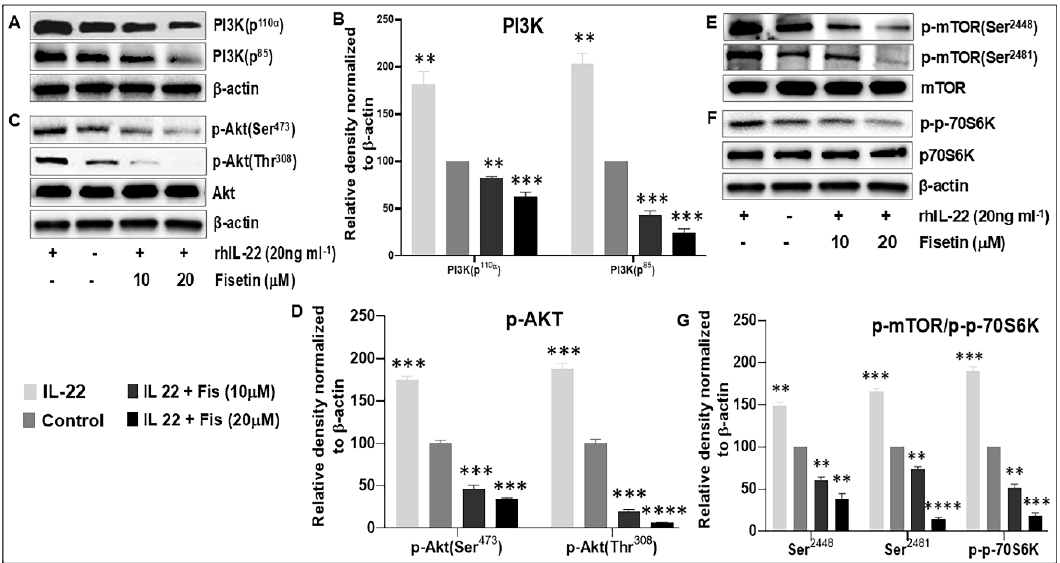
Figure 3. Fisetin significantly suppresses the IL-22-induced activation of PI3K/Akt/mTOR signaling in NHEK. Western blot determined protein expression levels of ( A , B ) PI3-K (p110 and p85), and ( C , D ) phosphorylation of Akt (at Ser473 and Thr308), and ( E ) phosphorylation of mTOR (at Ser2448 and Ser2481), and ( F ) phosphorylation of p-p70S6K (Thr389), as compared with untreated cells (control) and IL-22-treated cells only. ( B , D , G ) graphs of the relative intensity of normalized protein components, where each bar depict means +/-SD of three different experiments. **, *** and **** indicate p < 0.01, p < 0.001, and p < 0.0001 vs. control for IL-22-treated only or vs. IL-22 for fisetin- treated cells.